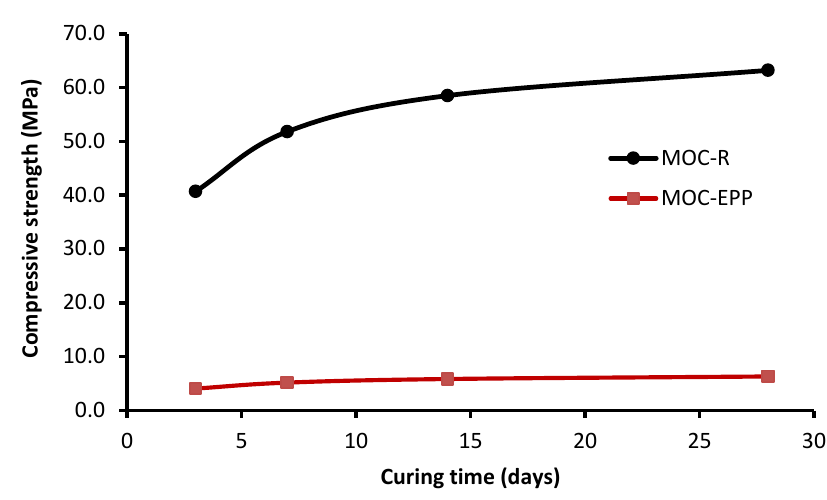
Figure 9. Compressive strength development of MOC-R samples.